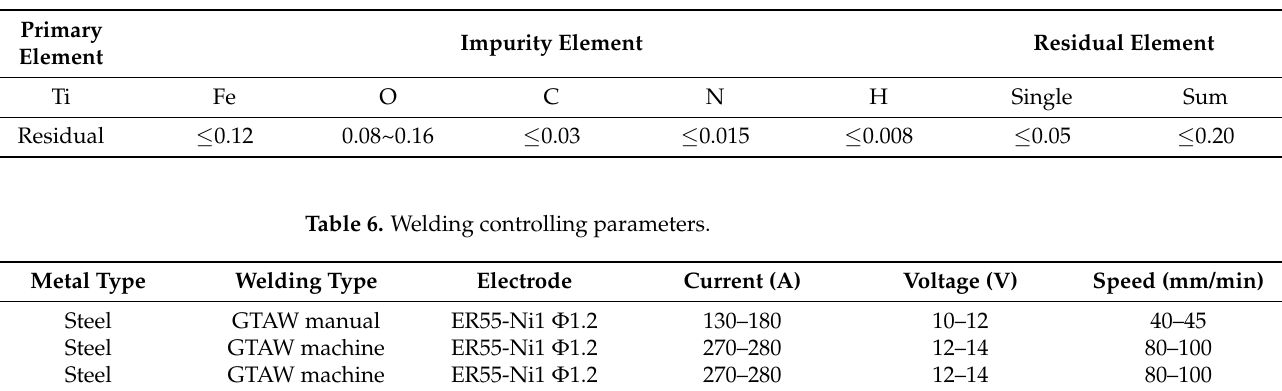
Table 5. Chemical composition of clad electrode ERTA2ELI (%).